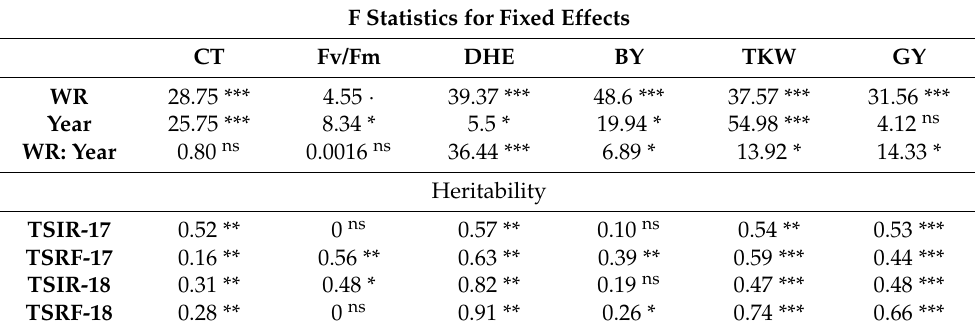
Table 4. F-statistics for the fixed effects (year and water regime (WR)) and heritabilities of traits of durum wheat lines across years and WR at Tessaout during the seasons 2016–2017 and